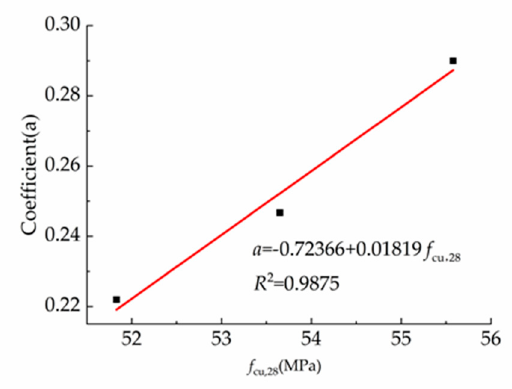
Figure 7. The relationship between the compressive strength and coefficient a.